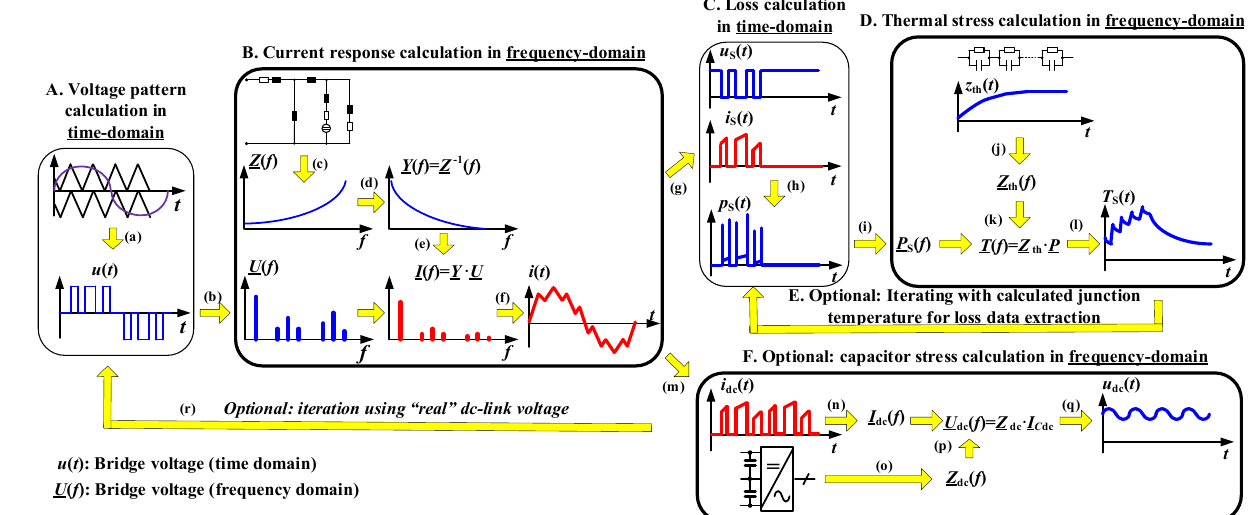
Figure 1. System block diagram of ScanTool.